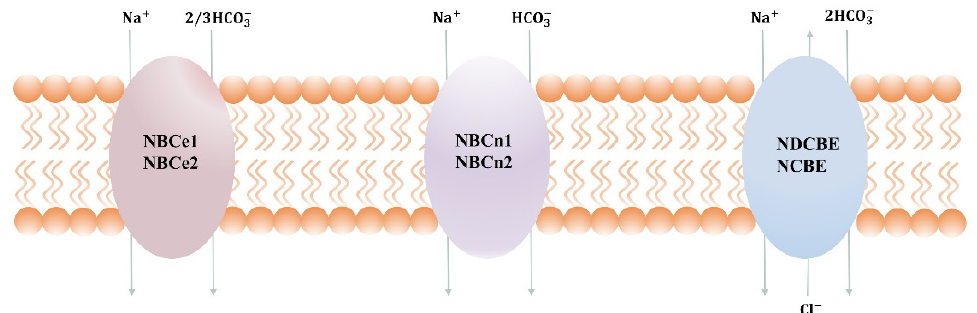
Figure 1. Transport stoichiometry of NBCs at intracellular (I) and extracellular (o) ion concentrations and membrane potentials. Note that NBCn2 and NCBE are the two alternative names suggested for SLC4A10, depending on whether the transporter mediates net Cl − transport or only Cl − self-exchange.